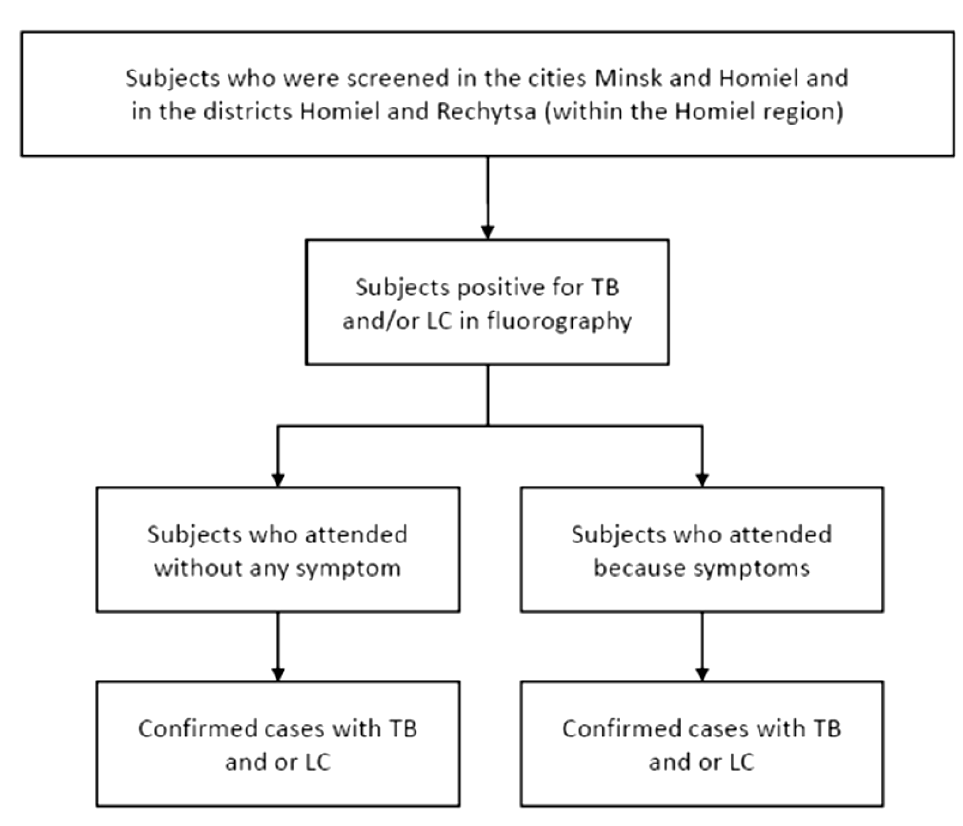
Figure 2. The design of the FLUTE study.